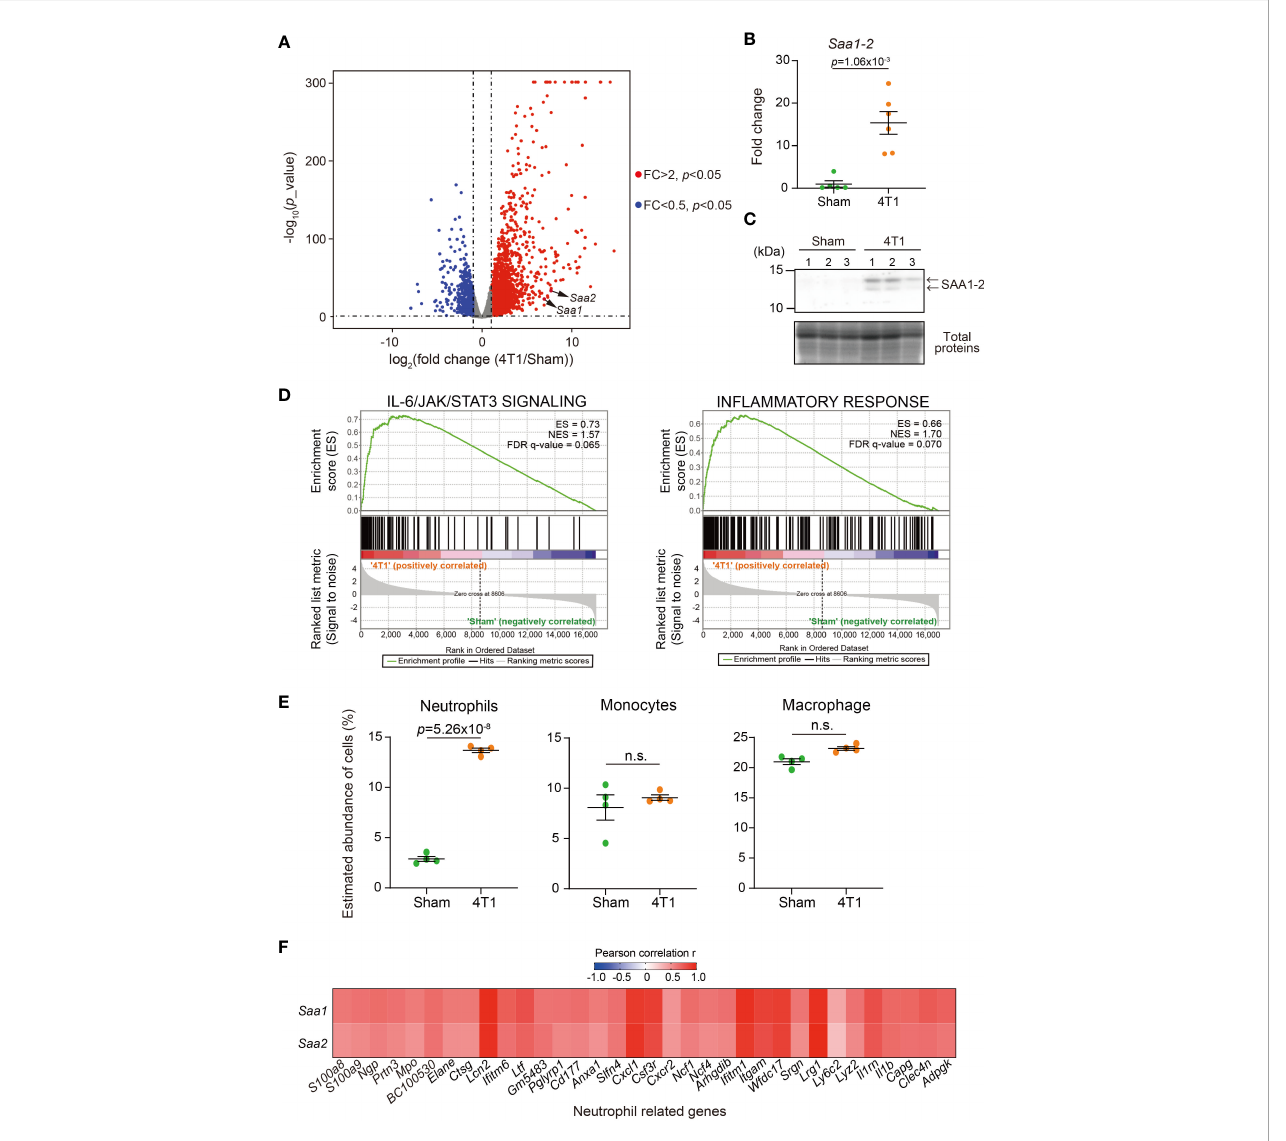
FIGURE 1 4T1 breast cancers elevate SAA1-2 in the liver (A) RNA-seq experiments for the livers of sham-operated mice and 4T1-bearing mice in WT (14 days after 4T1 transplantation). A volcano plot (log 2 (fold change (4T1/Sham)) versus – log 10 ( p value)) of WT is shown. Genes showing more than 2-fold change with p < 0.05 are highlighted. n = 4. (B) qPCR analysis of Saa1-2 in the livers of sham and 4T1-bearing mice. Averaged fold change data normalized to the sham group are presented as the mean ± SEM. The p value is shown (unpaired two-tailed Student ’ s t -test). n = 5 for sham-operated mice and n = 6 for 4T1-bearing mice. (C) Western blot analysis for SAA1-2 in the livers of sham and 4T1-bearing mice. n = 3. (D) GSEA plots that evaluate hepatic gene expression changes in “ IL-6/JAK/STAT3 signaling ” and “ In fl ammatory response ” upon 4T1 transplantation. FDR q value, enrichment score (ES), and normalized enrichment score (NES) are shown. (E) Dot plots showing the estimated abundance of the indicated immune cell types in the liver of sham and 4T1-bearing mice. The scores are calculated using the RNA-seq datasets in Figure 1A and ImmuCellAI-mouse. Data are mean ± SEM. The p value is shown (unpaired two-tailed Student ’ s t -test). n.s., not signi fi cant. (F) Heatmap representation of the correlations between Saa1-2 and representative neutrophil-related genes at mRNA level using the RNA-seq dataset (A) . n = 4. See also Figure